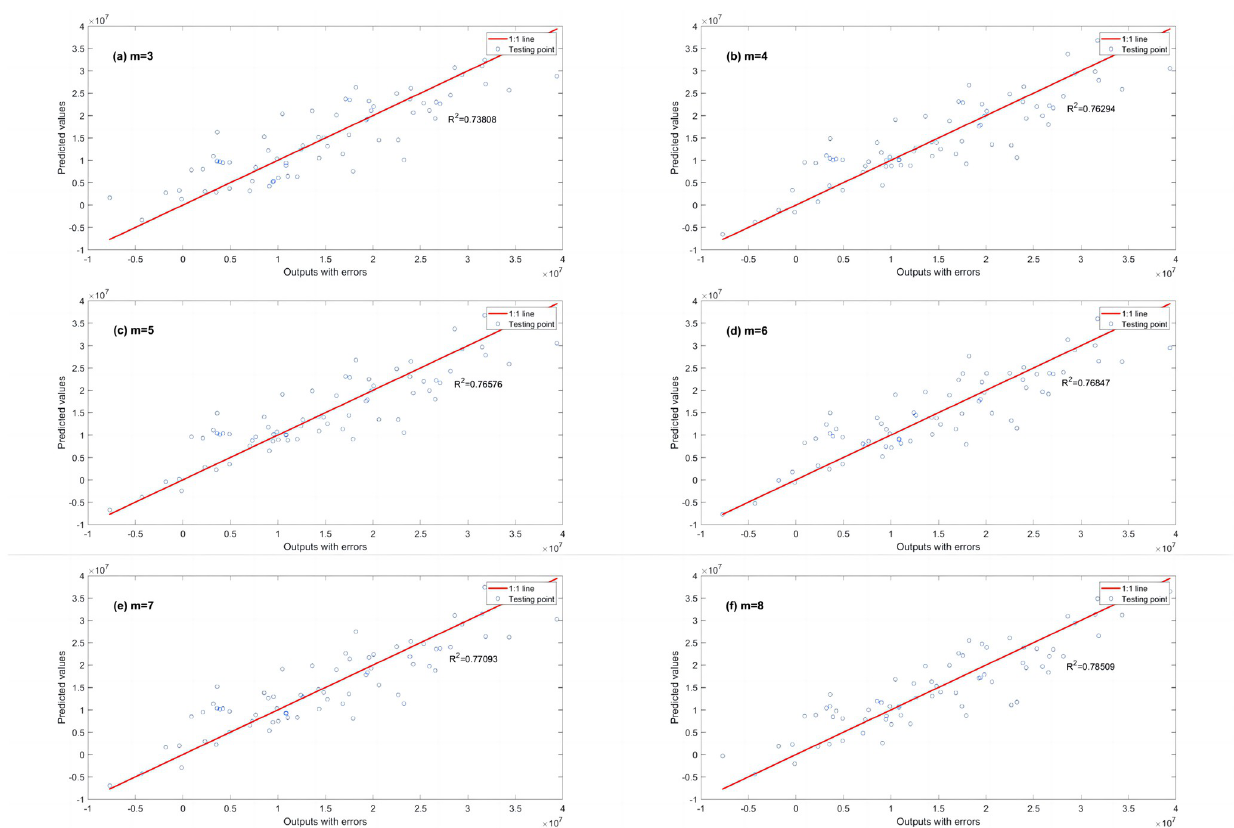
Fig 18. R 2 calculated by EPR with L2RM in dataset 4. (a) m = 3, (b) m = 4, (c) m = 5, (d) m = 6, (e) m = 7 and (f) m = 8.